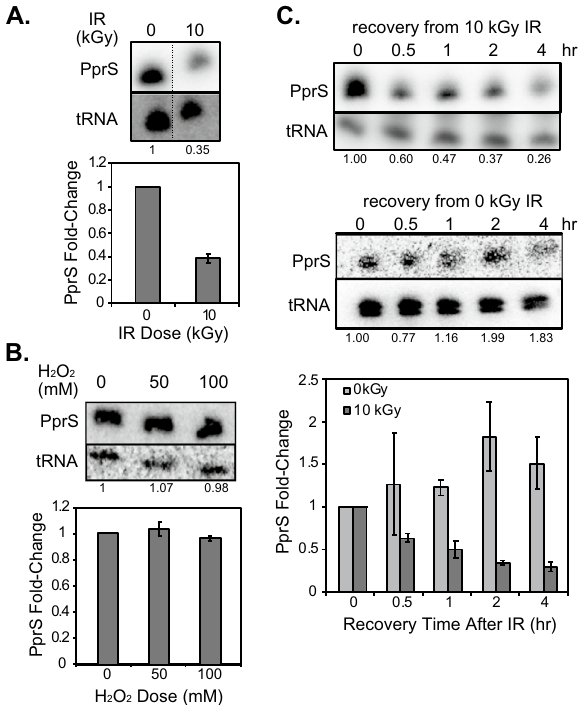
Figure 1. PprS demonstrates decreased expression under ionizing radiation, but not H 2 O 2 . ( A – C ) Representative Northern blotting images with bar graphs below demonstrating average fold-changes of PprS transcript levels ( B ) under 10 kGy of acute ionizing irradiation after 2 h recovery, ( C ) exposure to H 2 O 2 stress (50 and 100 mM), and ( D ) after different recovery times from 10 kGy irradiation. Numbers below each blot represents the normalized fold change for that replicate (PprS band intensity normalized to tRNA loading control, then normalized to the unstressed data for the corresponding Northern blot). Northern blots have been cropped to show specific bands of interest, but are from the same membrane for each boxed figure. Error bars in bar plot demonstrate standard deviation from separate experiments (n =